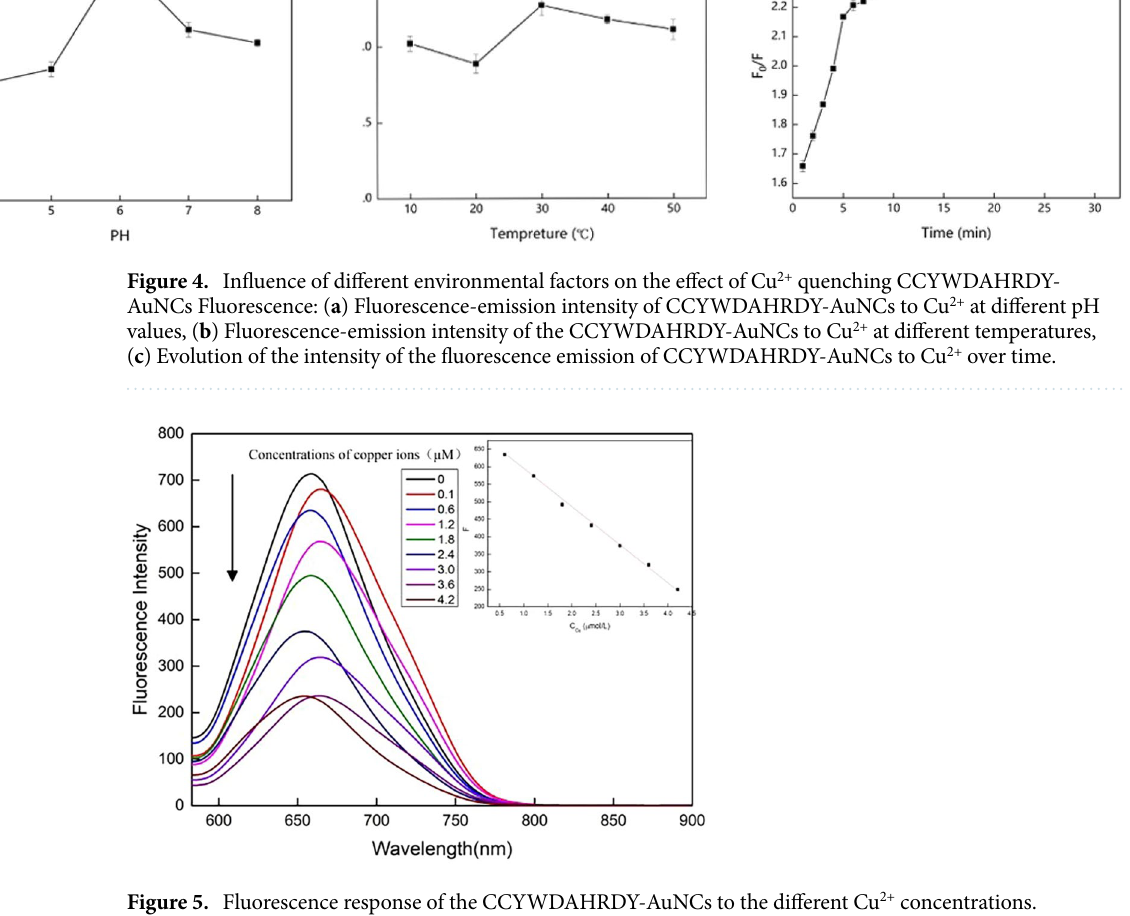
Figure 5. Fluorescence response of the CCYWDAHRDY-AuNCs to the different Cu 2+